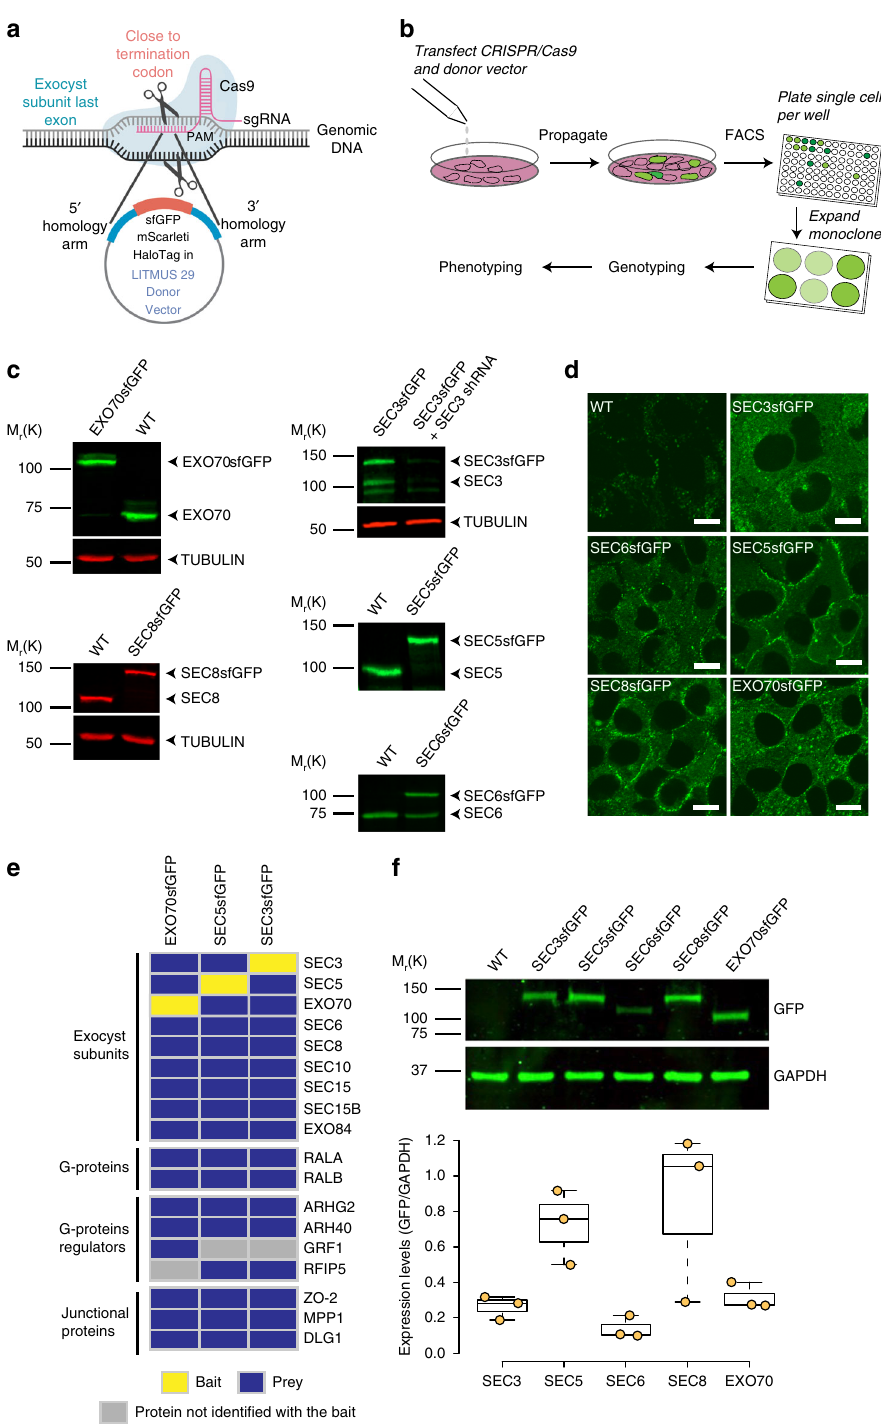
Fig. 1 Establishment and validation of tagged exocyst subunit cell lines. a Schematic showing a region of subunit gene targeted by sgRNA and tags to be inserted C-terminally, in-frame with the coding region. b Strategy to isolate CRISPR/Cas9-mediated sfGFP-tagged clones of exocyst subunits in NMuMG cells. c Western blots with subunit speci fi c antibodies show successful incorporation of sfGFP in both alleles (EXO70, SEC5, and SEC8), or in one allele (SEC3 and SEC6). A shRNA speci fi c to SEC3 was used to con fi rm the identity of multiple bands in the blot. d Confocal images of live wild-type NMuMG cells and endogenously tagged SEC3-GFP, SEC5-GFP, SEC6-GFP, SEC8-GFP, and EXO70-GFP cell lines. Scale bar = 10 μ m. e Protein – protein interaction heat map for endogenous SEC3-GFP, SEC5-GFP, and EXO70-GFP pulldown using GFP-Trap nanobodies and MS. Yellow indicates baits, blue the protein identi fi ed with high con fi dence, and gray denotes preys that were not identi fi ed. The experiments were repeated three times for EXO70-GFP and twice for SEC3-GFP and SEC5-GFP. All experiments were also partially con fi rmed by IP – WB in at least three independent experiments, with similar results. f Western blot analysis to assess the relative abundance of exocyst subunits fused to sfGFP, using anti-GFP antibodies (SEC3 and SEC6 quanti fi cations corrected for heterozygosity). GAPDH was the loading control. Y axis shows the ratio of GFP/GAPDH. Quanti fi cation shows pooled data from